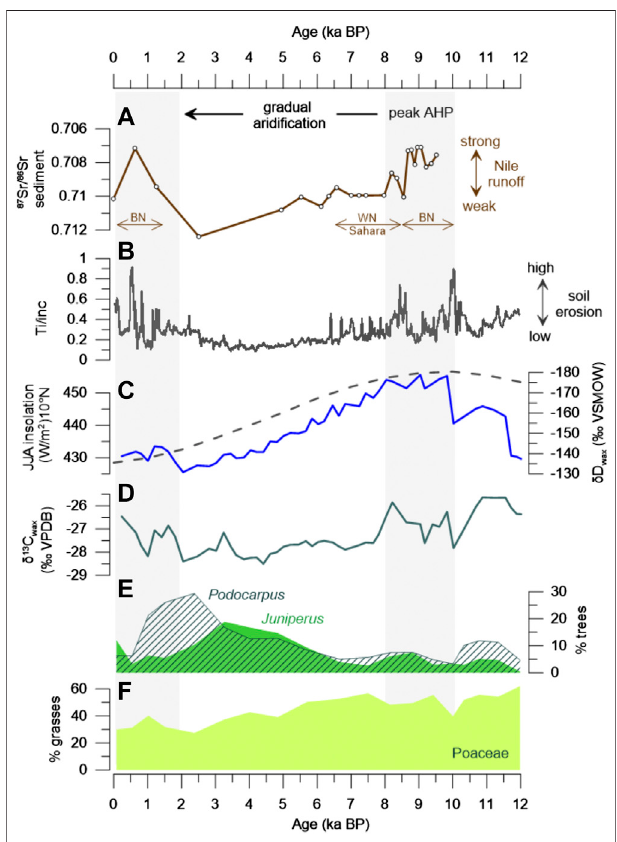
FIGURE 7 | Changes in precipitation and vegetation at Lake Dendi and river runoff in the Nile watershed during the Holocene. (A) Sediment sources from the Blue Nile (BN), White Nile (WN) and Sahara as estimated from the radiogenic Sr isotope signature in a marine sediment core from the Nile deep-sea fan (Blanchet et al., 2014). (B) Changes in catchment erosion at Lake Dendi based on Ti XRF-counts (Wagner et al., 2018). (C) Lake Dendi δ D wax record indicating changes in rainfall in the Ethiopian highlands (this study). Mean JJA insolation at 10 ° N (Berger and Loutre, 1991) is indicated as gray dashed line. (D) Lake Dendi δ 13 C values of n -C 29 indicate increasing contribution of C 3 vegetation (trees) from the late to the mid Holocene (this study). (E) , (F) Lake Dendi pollen percentages of predominant trees and grasses,respectively(this study). Verticalgray bars markperiods ofenhanced Nile river runoff during high rainfall in the BN